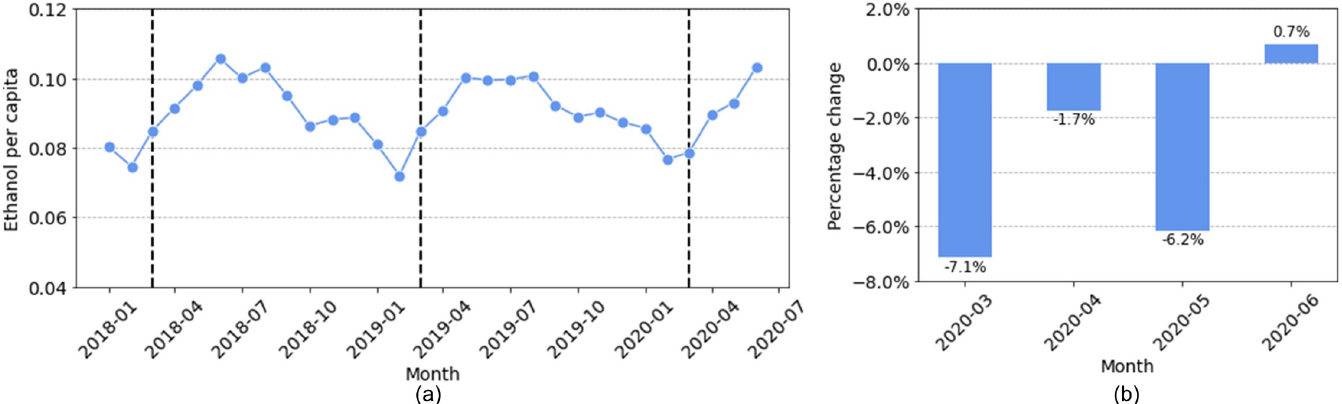
Fig 7. Total beer sales in eleven states: (a) sales from January 2018 to June 2020 (the dashed lines indicate the month of March in 2018, 2019, and 2020); (b) sales changes in 2020 compared with the average sales in the same month of 2018 and 2019.